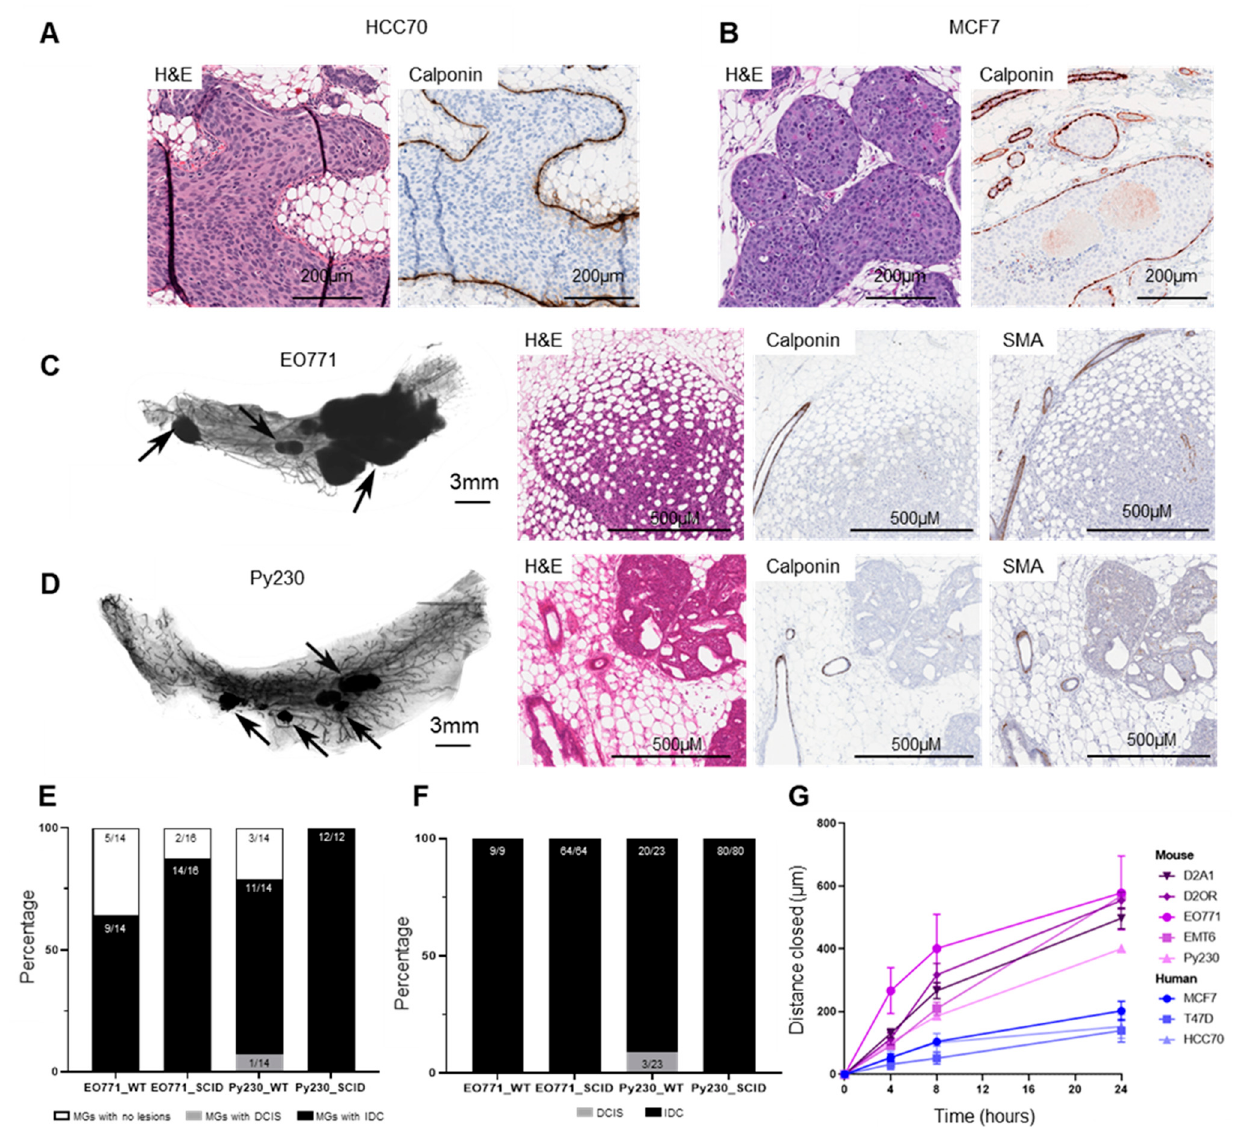
Figure 5. Characterization of tumors derived from intraductal injection of human breast cancer and mammary cancer cell lines into C57BL/6/SCID immunocompromised hosts. Representative hema- toxylin–eosin stain and immunohistochemical analysis of calponin in mouse mammary glands